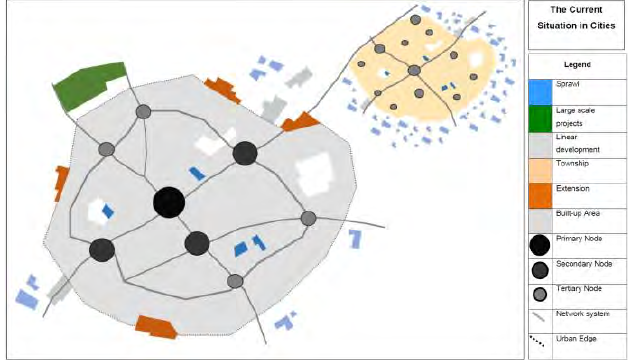
Figure 2: Current dualistic cities Source: Richter,